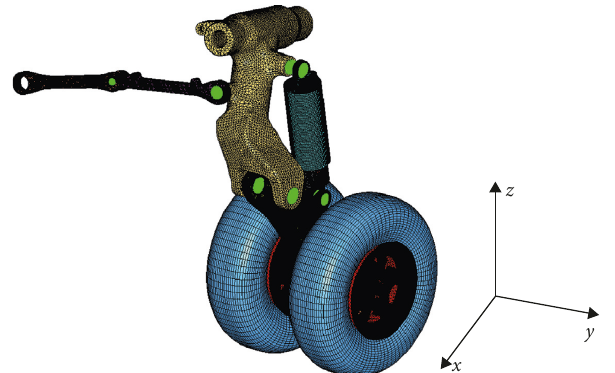
Figure 11: FE model.